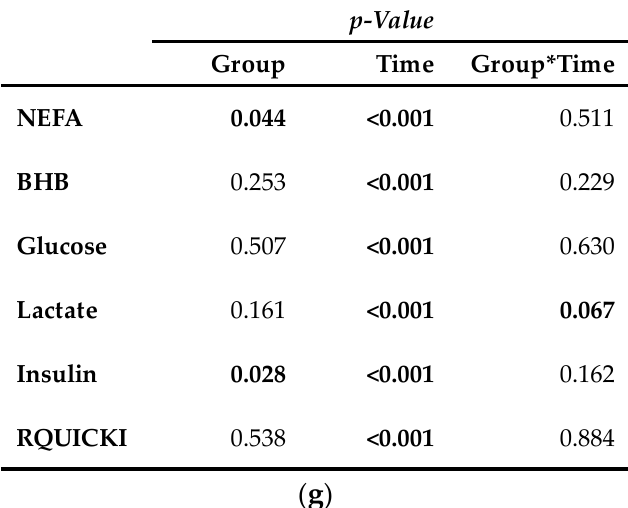
(cid:2869) ( g ) logInsulin [ µ U ml ] + logGlucose [ mg dl ] + logNEFA [ mmol l ] (cid:4675)(cid:2878)(cid:2922)(cid:2925)(cid:2917)(cid:2891)(cid:2922)(cid:2931)(cid:2913)(cid:2925)(cid:2929)(cid:2915)(cid:4674) (cid:3171)(cid:3165) (cid:4675)(cid:2878)(cid:2922)(cid:2925)(cid:2917)(cid:2898)(cid:2889)(cid:2890)(cid:2885)(cid:4674) (cid:3171)(cid:3171)(cid:3173)(cid:3170) (cid:4675) (cid:2922)(cid:2925)(cid:2917) (cid:2893)(cid:2924)(cid:2929)(cid:2931)(cid:2922)(cid:2919)(cid:2924) (cid:4674) µ(cid:3153) (cid:3171)(cid:3170) (cid:3162)(cid:3170) (cid:3170)